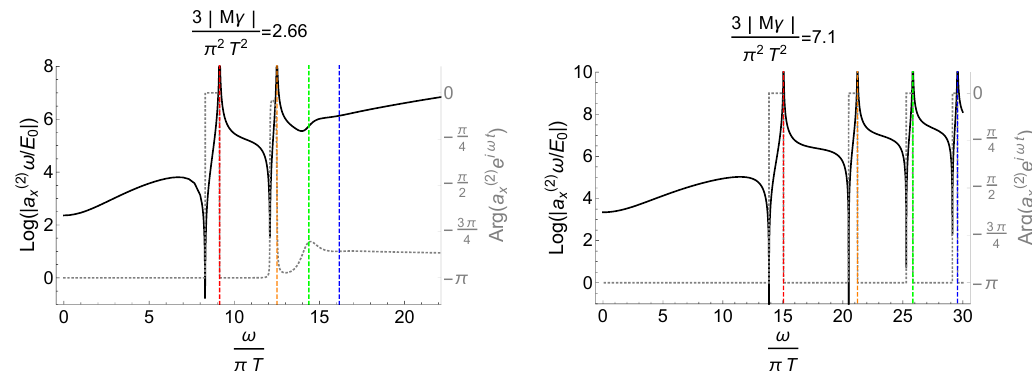
Figure 5 . Plots of the dependence of a (2) x (proportional to the current J x via (2.15)) on the driving frequency for two values of the magnetic (cid:12)eld. The absolute value of a (2) x !=E 0 is speci(cid:12)ed by a solid dark line whose scale appears to the left of the plot whereas the phase of a (2) x relative to the phase of the driving force e (cid:0) i!t is speci(cid:12)ed by a dashed gray line whose scale appears to the right of the plot. The dashed vertical lines specify the location of the real part of the quasi normal modes, color coded as in (cid:12)gure 4. For the left plot, the lowest quasi normal mode ! 0 =(cid:25)T takes the approximate value 9 : 14 (cid:0) 3 (cid:2) 10 (cid:0) 6 i whereas for the fourth quasi normal mode we (cid:12)nd ! 4 =(cid:25)T (cid:24) 16 : 16 (cid:0) 2 : 19 i . For the right plot we (cid:12)nd ! 0 =(cid:25)T (cid:24) 15 : 05 (cid:0) 2 : 2 (cid:2) 10 (cid:0) 25 i and ! 4 =(cid:25)T (cid:24) 29 : 56 (cid:0) 1 : 92 (cid:2) 10 (cid:0) 8 i .